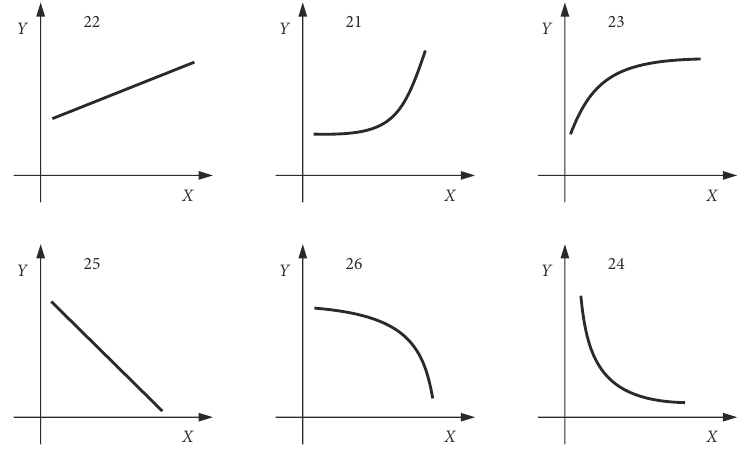
Figure 1. Examples of pairwise trend relations (source: Doubravský & Dohnal,